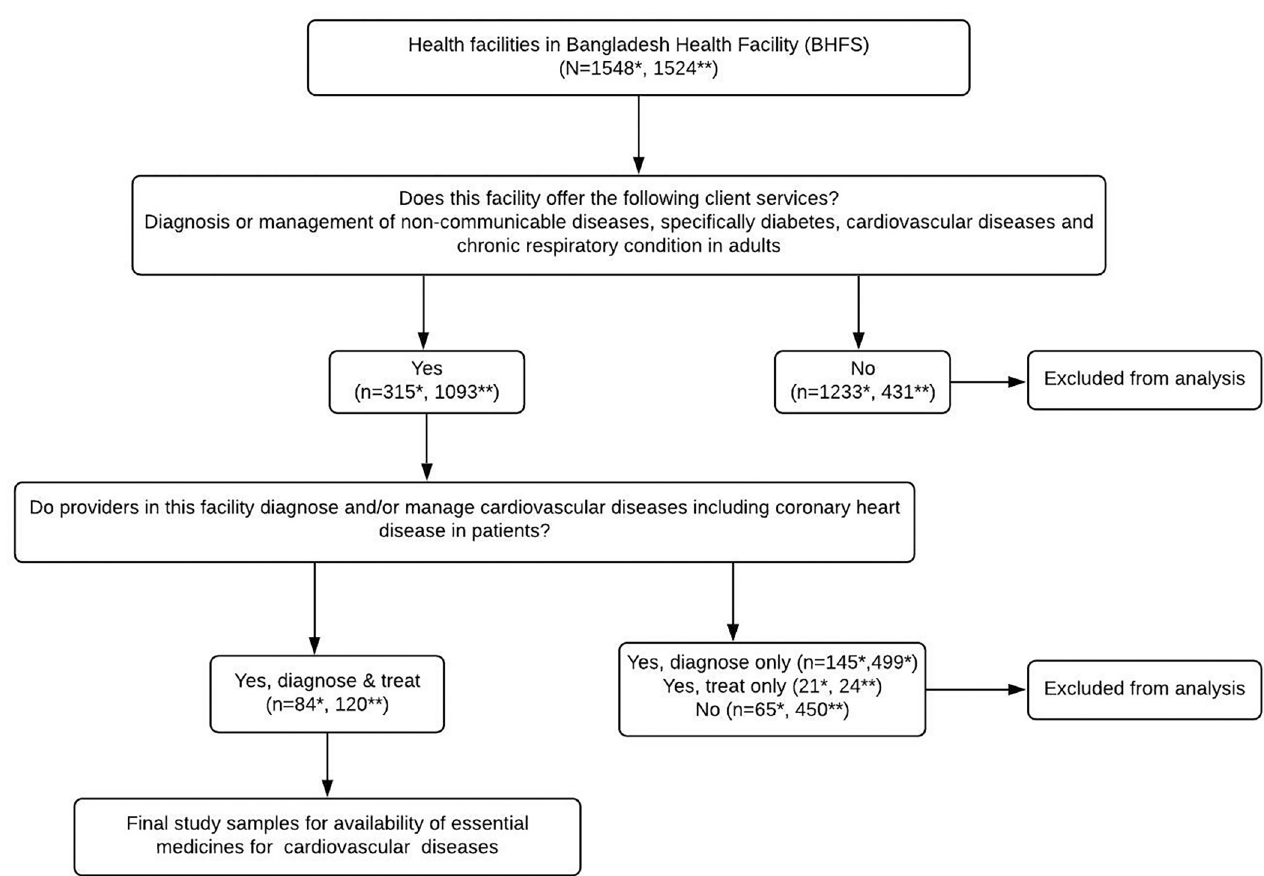
Fig 1. Flow chart of study samples selection. The star (stars) in the figure is a sign indicating the number of healthcare facilities in the 2014 and 2017 BHFS, respectively. One star indicates the facilities from the 2014 survey, and the sign with two stars indicates the facilities from the 2017 survey. Numbers in the parentheses represent weighted